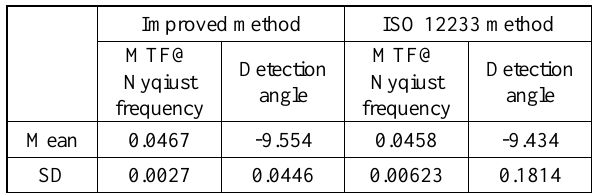
Table 5. The estimated MTF of GF-1 panchromatic image (Cross-track, SNR of MTF=70)